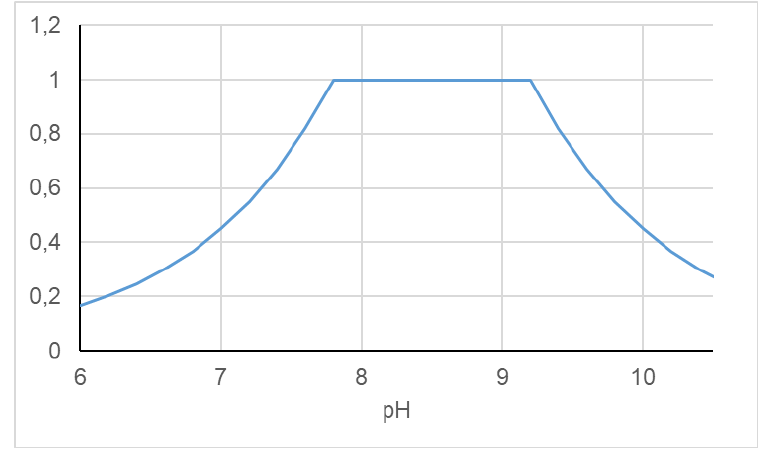
Figure A1. Correction factor pH nit_corr for the effect of pH on the nitrification rate, from [22].